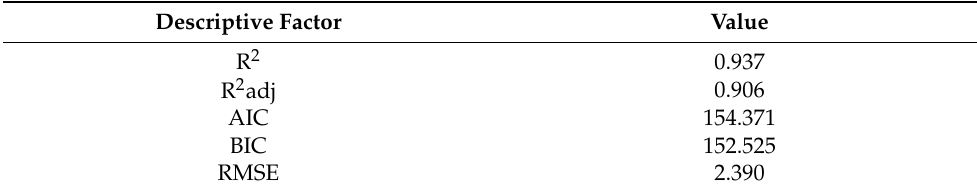
Table 5. Summary of fit.